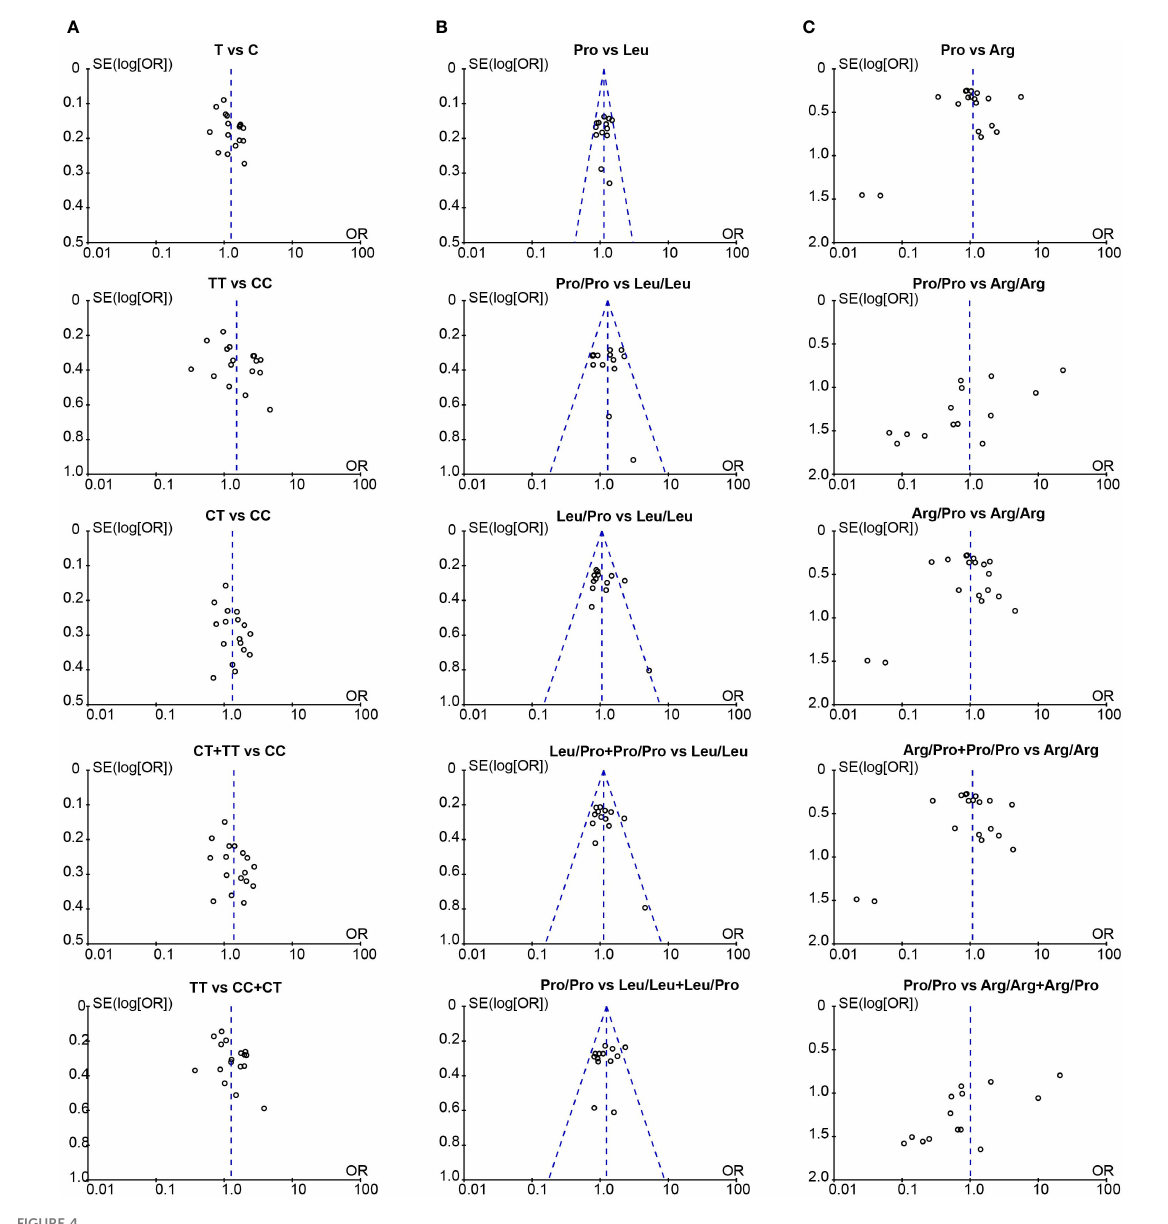
FIGURE 4 The funnel plot for publication bias assessment in the meta-analysis. (A) Funnel plot of TGF- b 1 -509C/T polymorphism and CLD risk; (B) Funnel plot of TGF- b 1 codon 10 polymorphism and CLD risk; (C) Funnel plot of TGF- b 1 codon 25 polymorphism and CLD risk. T, Thymine; C, Cytosine; Pro, Proline; Leu, Leucine; Arg,